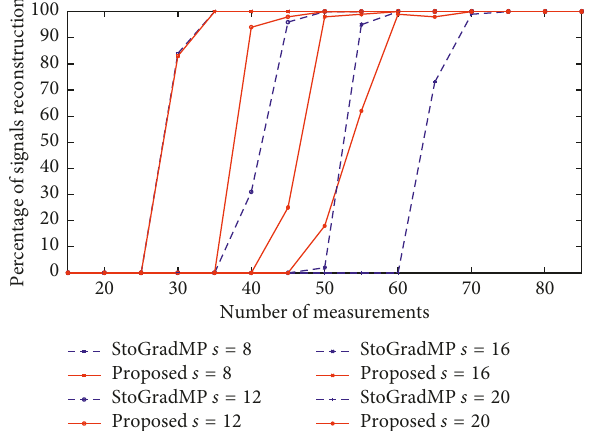
Figure 5: Reconstruction probability of different sparsities of the StoGradMP and proposed algorithms with different measurements ( n 256, t 0 . 6, s 8 , 12 , 16 , 20 , Gaussian signal). (cid:31) (cid:31) [ ] ∈